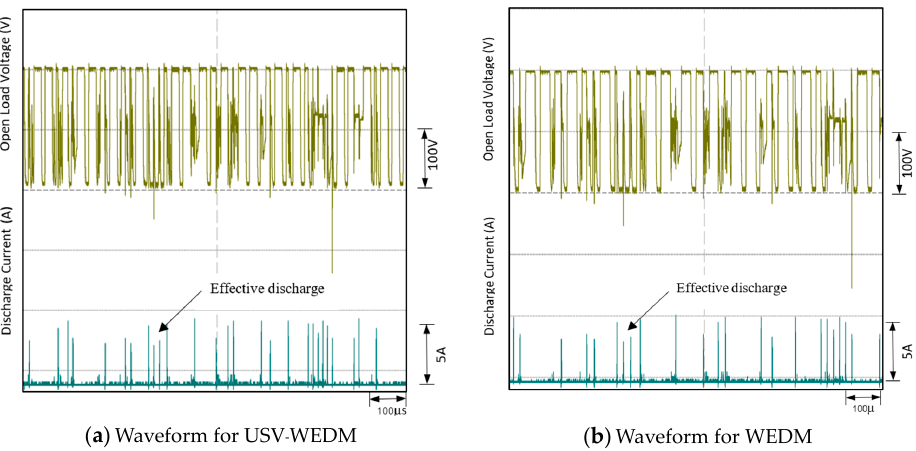
Figure 12 . Discharge waveform for ( a ) USV - WEDM and ( b ) WEDM . Figure 12. Discharge waveform for ( a ) USV-WEDM and ( b )